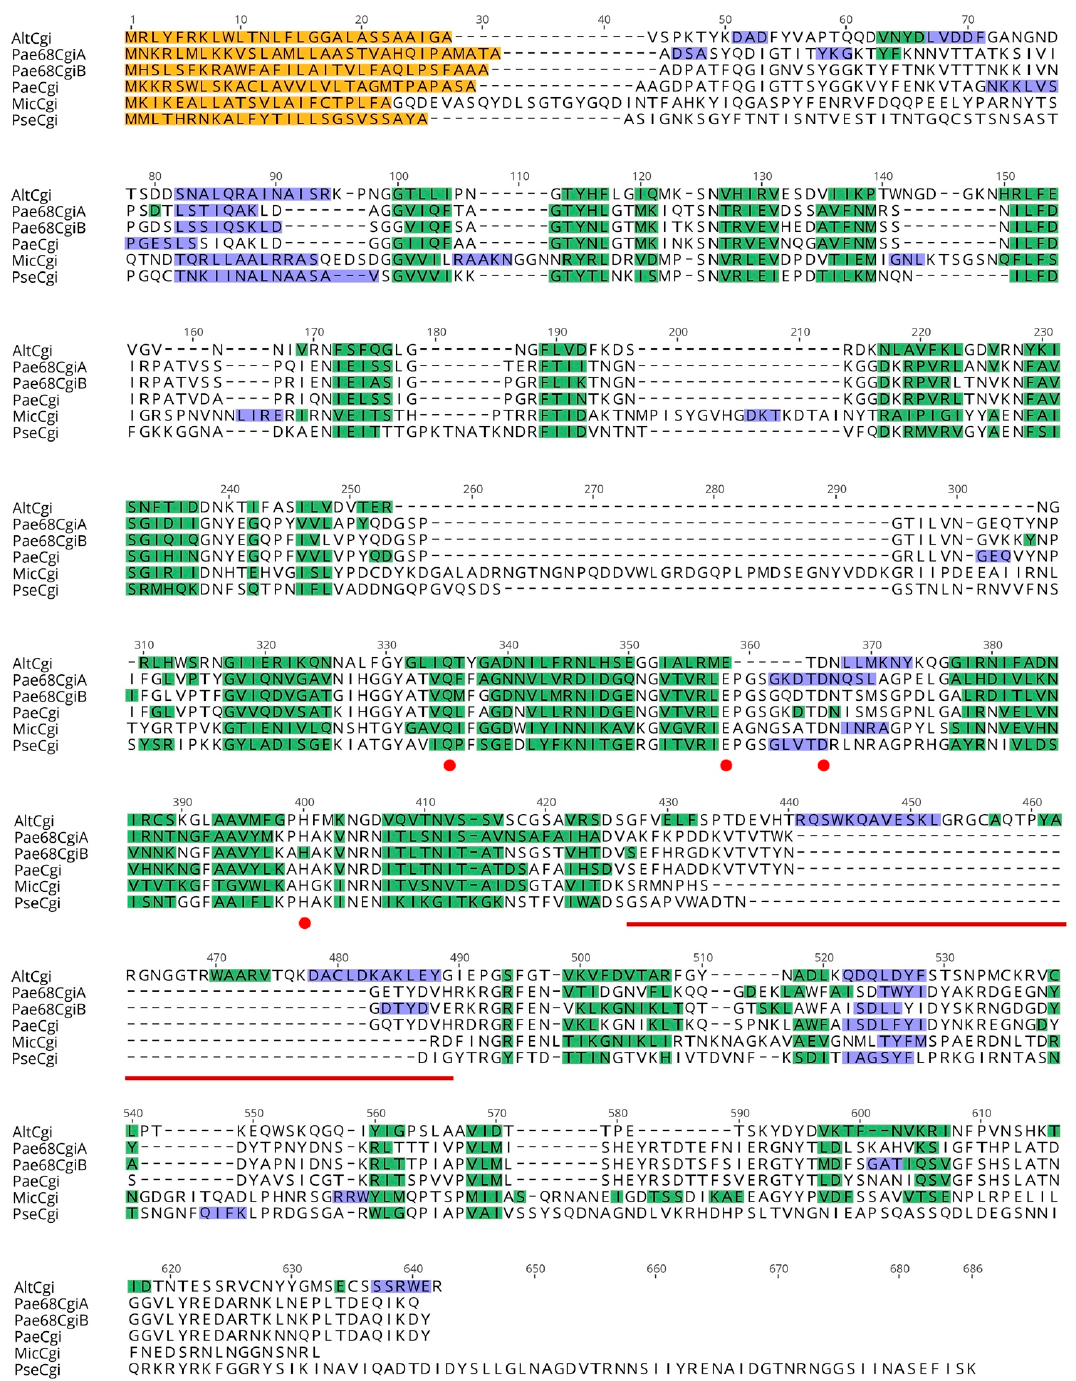
Figure 5. Multiple amino acid sequence alignment of the ι -carrageenase candidate proteins CgiA (Pae68CgiA) and CgiB (Pae68CgiB) of Paenibacillus strain YYML68 in comparison to reported ι -carrageenases. The ι -carrageenases from Paenibacillus sp. HB172198 (PaeCgi), Microbulbifer thermotolerans JAMB-A94 (MicCgi), Pseudoalteromonas atlantica T6c (PseCgi) and Alteromonas fortis (AltCgi) were used as the reference sequence. Amino acid residues highlighted in green and purple indicate ß-sheets and α -helix attained from predicted 3D models constructed using SWISS-MODEL. The red underline indicates domain A, and red dots indicate the important residues required for carrageenan degradation, as presented by Martin et al.